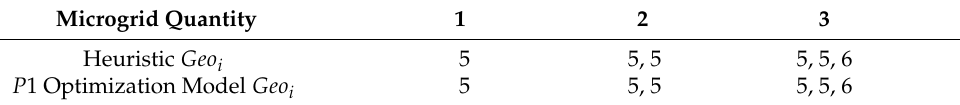
Table 10. Optimization vs. Heuristic represented by square numbers.